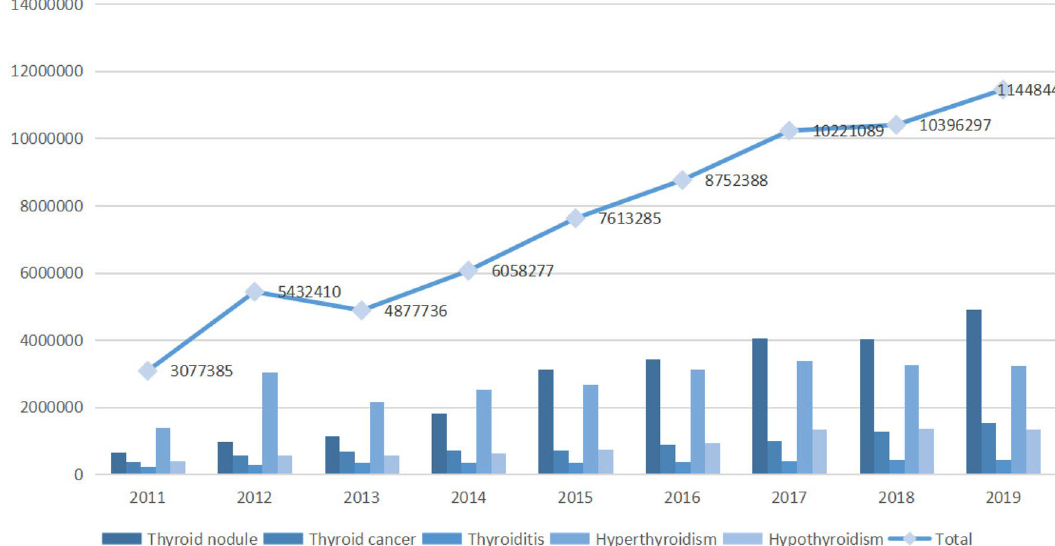
Figure 1. Changes in the annual search index.